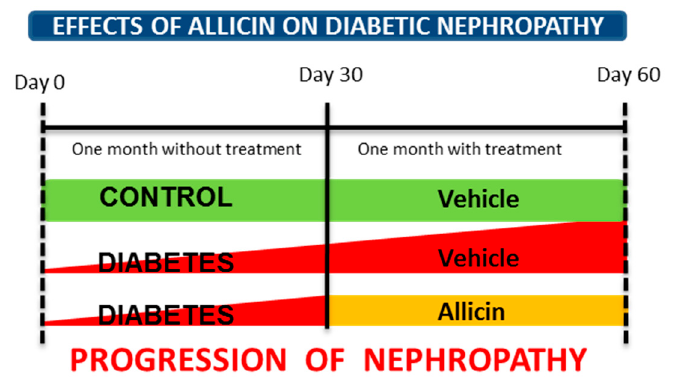
Figure 1. Experimental design to assess the effects of allicin on progression of diabetic nephropathy. After one month of follow-up, the treatments were started and given for one month.